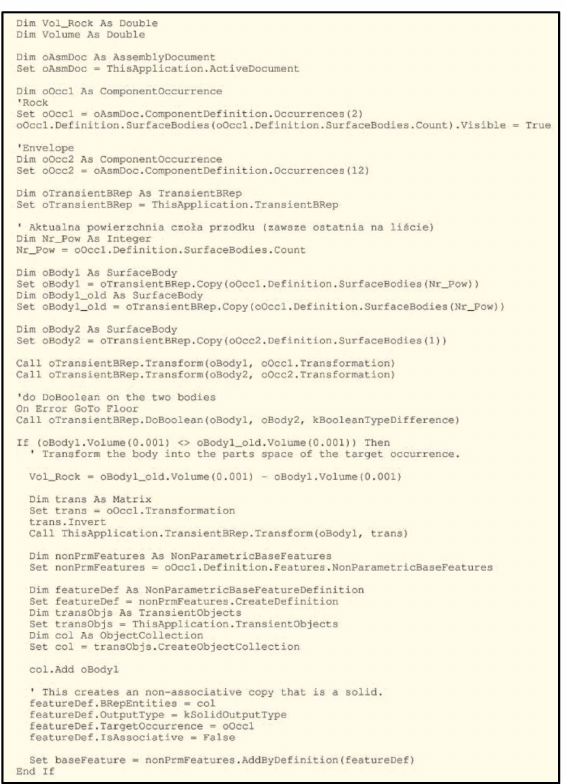
Figure A1. A fragment of the script source code to execute in the Autodesk Inventor environment, in which the Envelope and Rock solids are subtracted during the simulated cutting of the heading face with the cutting heads of a